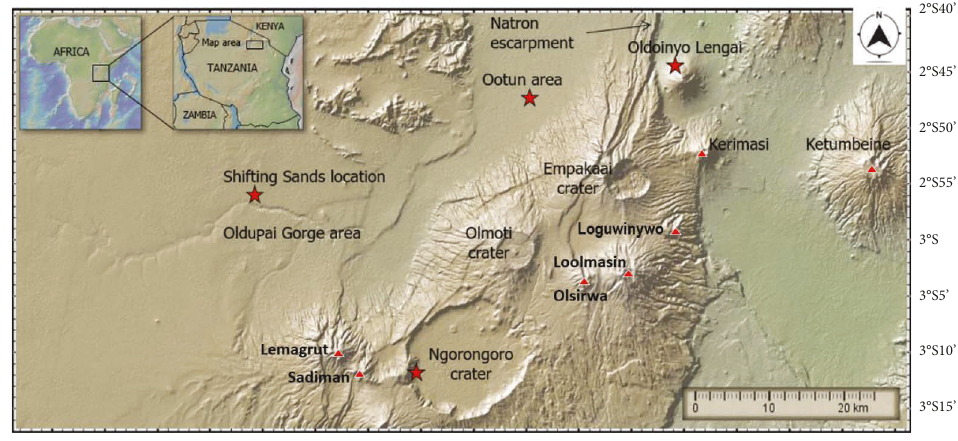
Figure 1: A map of part of the northern Tanzanian sector of the Gregory Rift was modified by the GeoMapApp global multiresolution topography [14], to show the study sites. The red star points are the four sampling locations.